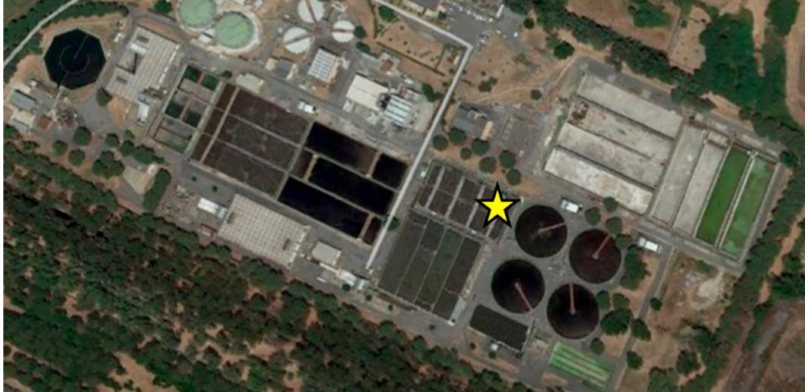
Figure 1. Wastewater treatment plants with the oxidation aeration tanks highlighted by the yellow